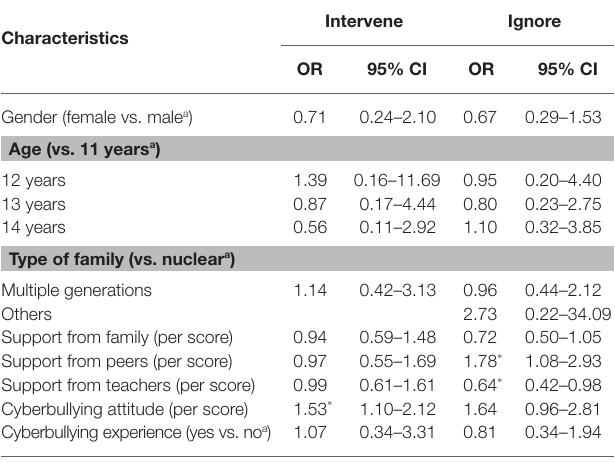
TABLE 5 | Associated factors with different types of cyberbullying observation.